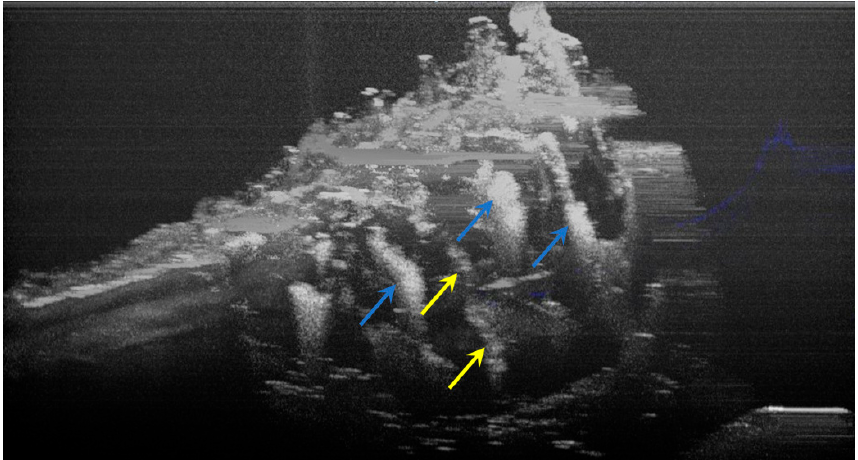
Figure 6. Three-dimensional OCT reconstruction of hypomineralization areas (Axis 0Y). The blue arrows indicate three well-defined areas; the yellow arrows indicate several small-size diffuse ar- eas.